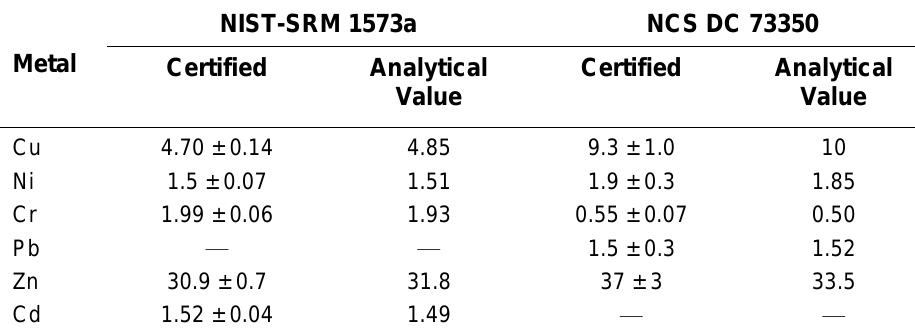
Analysis of the Biological Standard (NIST) and Certified (NCS)